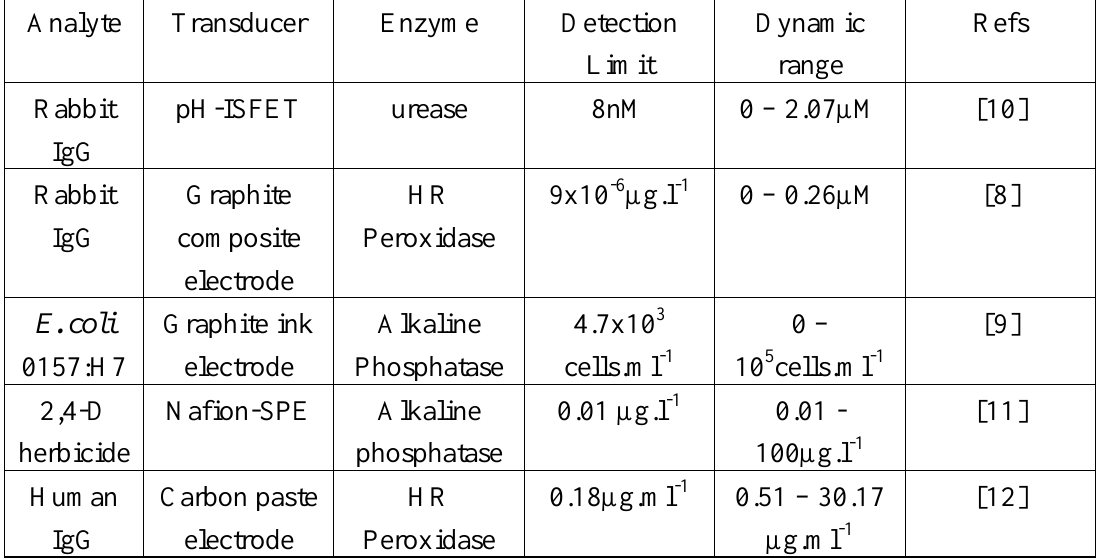
Table 2. Features of enzyme-linked immunomagnetic electrochemical assays using different electrochemical transducers and different enzymatic labels.